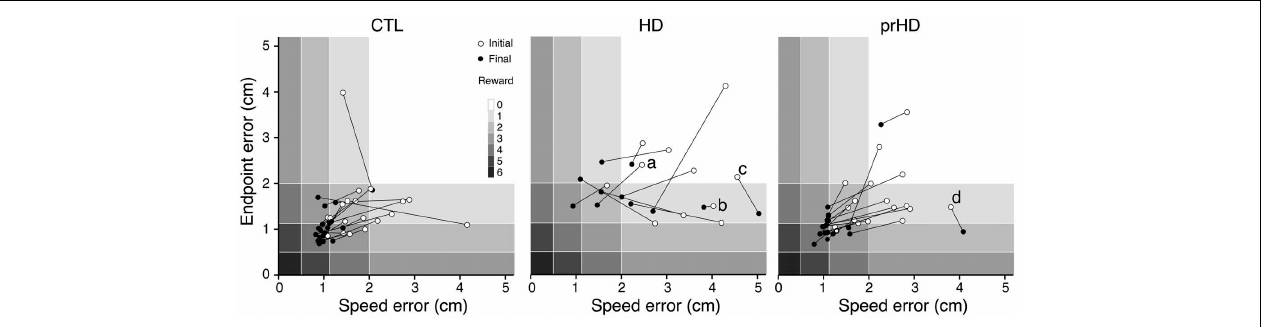
FIGURE 4 | Initial and final performance of individual subjects in task performance space. The progression of skill error in performance space is shown as plots of initial (open circle) and final (closed circle) endpoint error